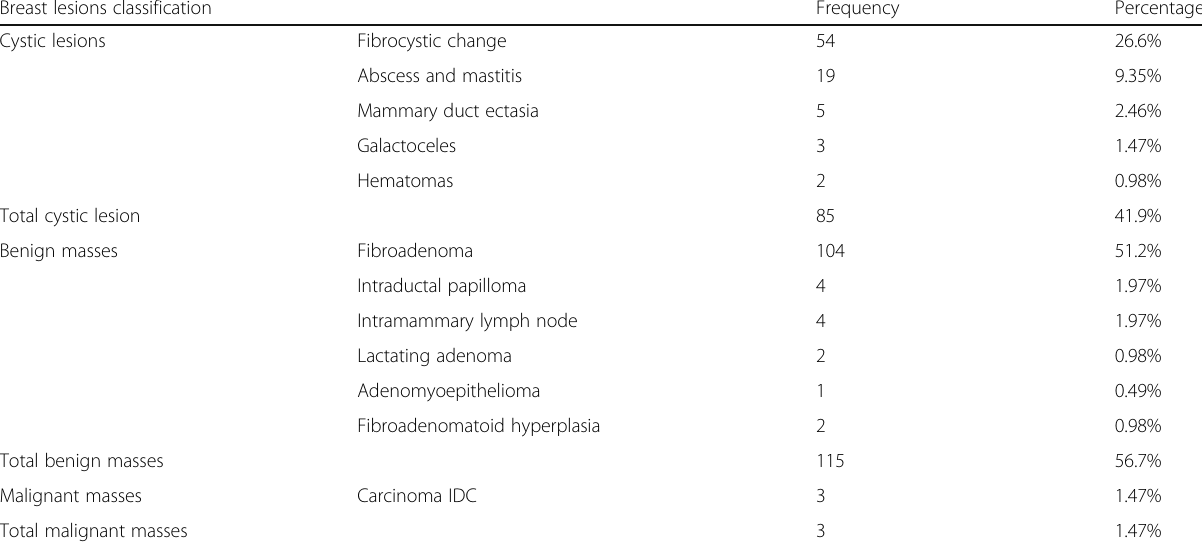
Table 4 Types, frequency, and percentage of the breast lesion in the examined young female Breast lesions classification